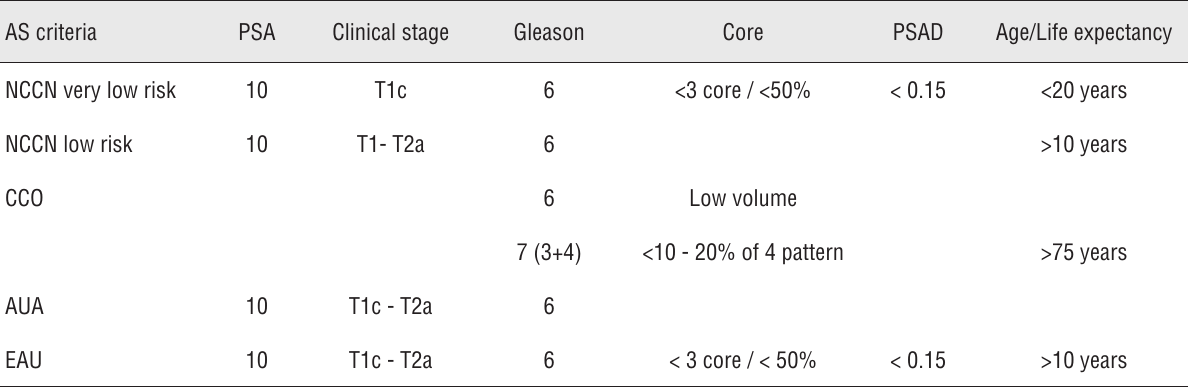
Table 1 - commonly utilized clinicopathologic criteria for active surveillance. AS criteria PSA Clinical stage Gleason